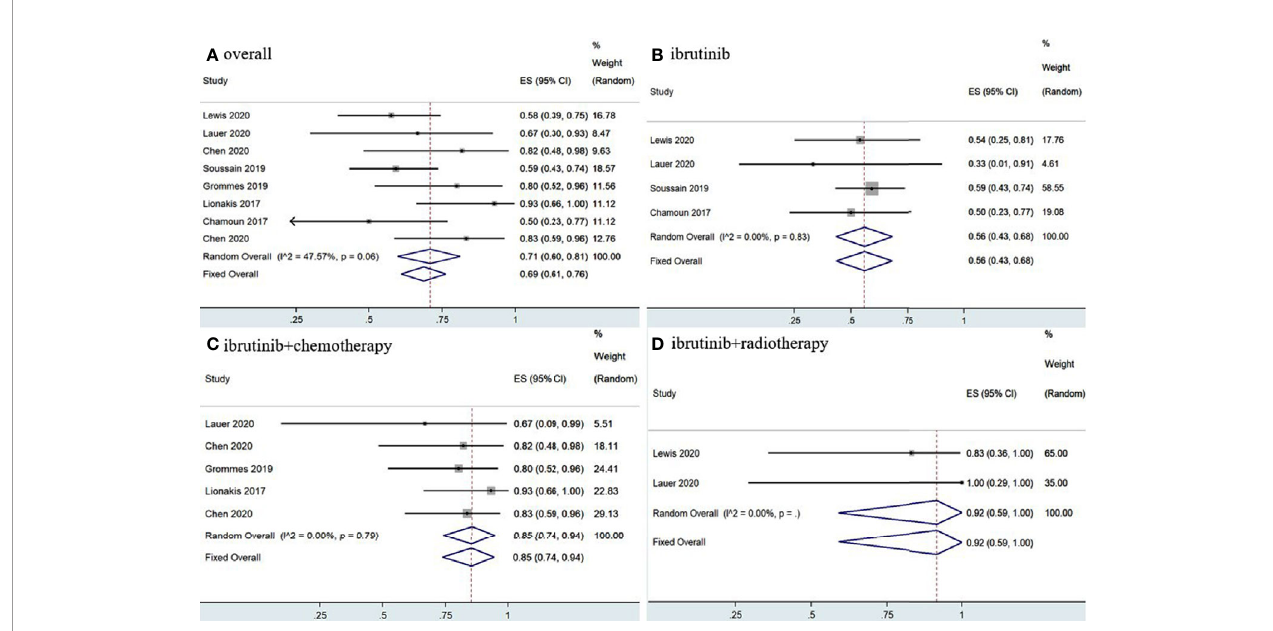
FIGURE 2 | Pooled overall response of central nervous system lymphoma. (A) Ibrutinib-based regimens. (B) Ibrutinib monotherapy. (C) Ibrutinib combined with chemotherapy. (D) Ibrutinib combined with radiotherapy.